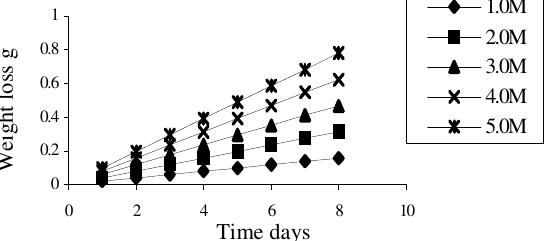
Figure 1. Variation of weight loss (g) of mild steel with time (days) for different concentrations of HCl solution at 30 o C.